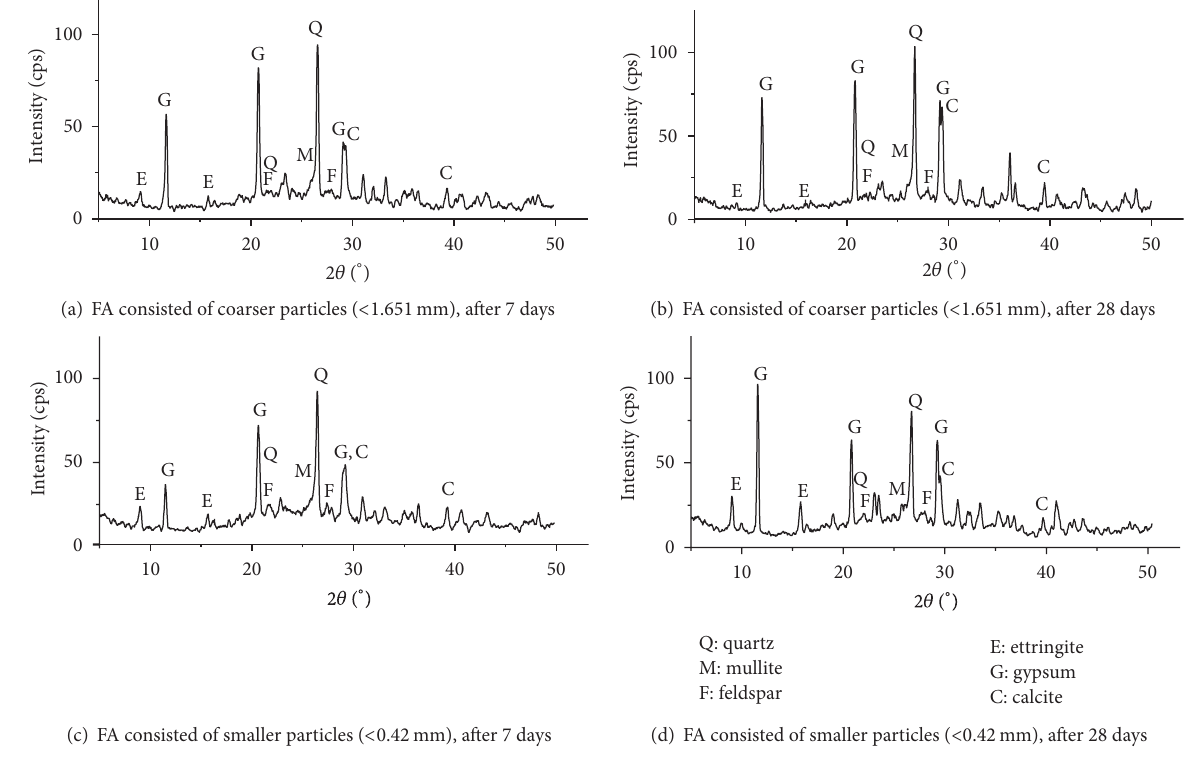
F 1: XRD diffractograms of the mixture FA-PC-FGD gypsum-BA-W. T 4: e intensity of the peaks of ettringite and